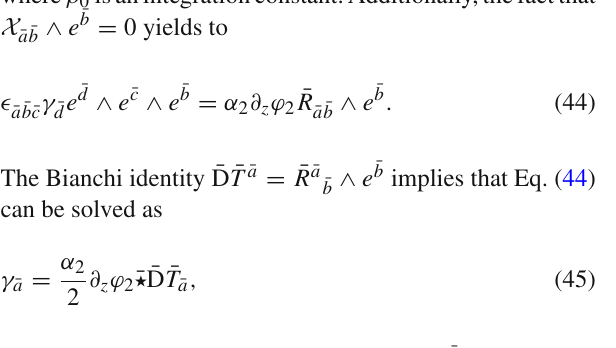
Table 1 The BTZ black strings (50) solve the field equations (35), provided the torsional configurations (43) and (48) with the integration constants β 0 , t 0 and λ i fixed as shown in this table. The (non-)Riemannian AdS curvature radii ( (cid:17) i ) ˜ (cid:17) i are presented for each case separately